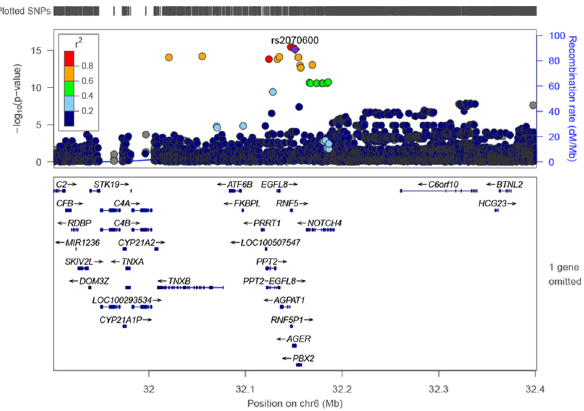
Fig 2. Regional association plot for genome-wide significant locus ( AGER ) in whites.